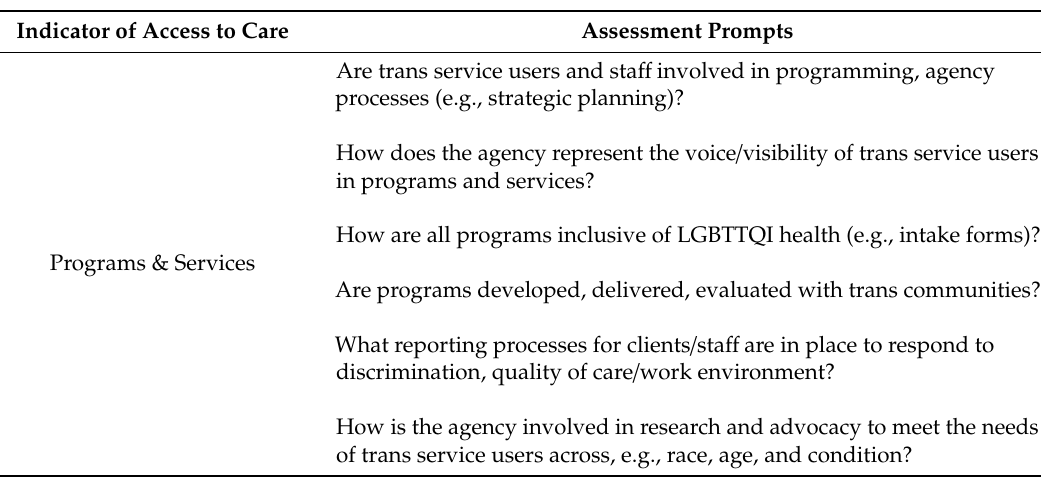
Table 4. Assessing high-quality and equitable service for trans